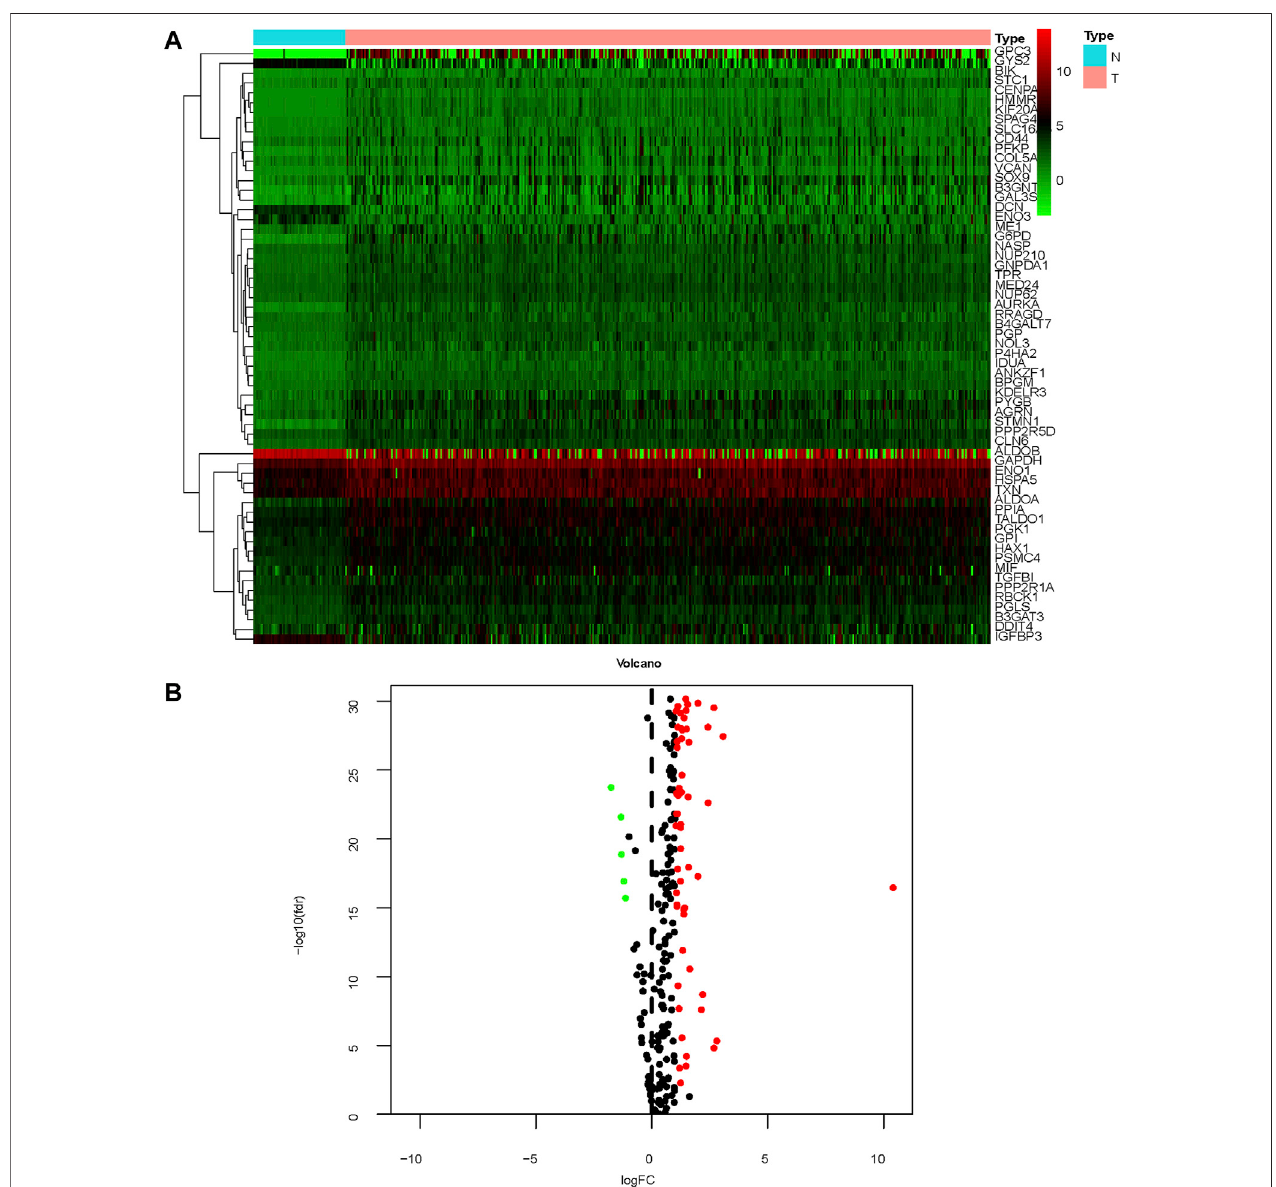
FIGURE 2 | Gene expression pro fi les of patients with HCC (A) Heatmap; (B) mRNA volcano